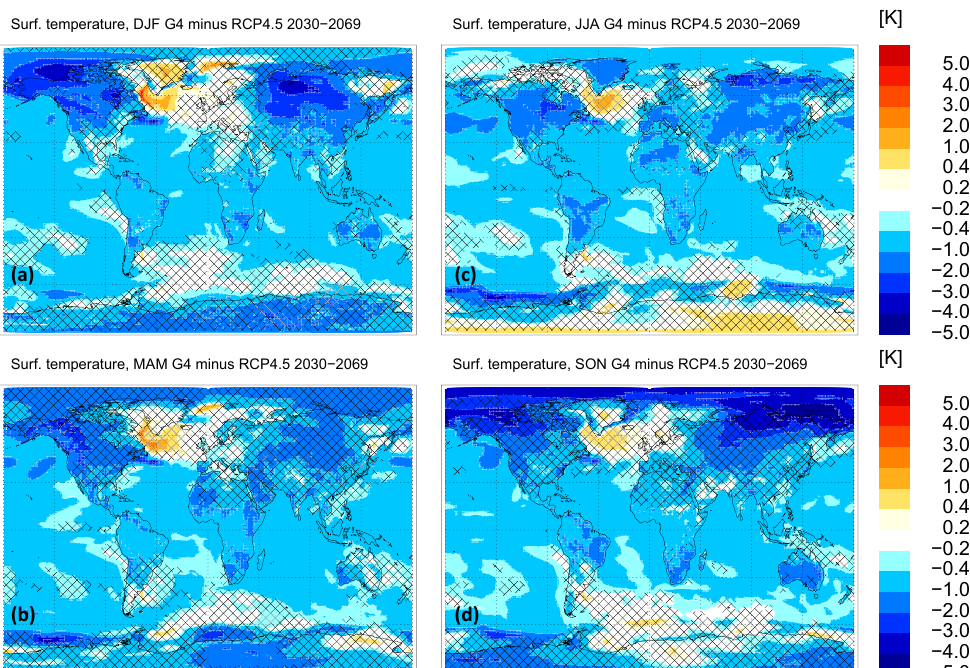
Figure 5. Seasonally averaged surface temperature anomalies G4-RCP4.5 (K) from the CCSM-CAM4 atmosphere–ocean coupled model (time-averaged over the years 2030–2069). The shaded areas are not statistically significant within ± 1 σ . Panels (a) – (d) refer to the following periods: December–January–February (a) ; March–April–May (b) ; June–July–August (c) ; and September–October–November (d)